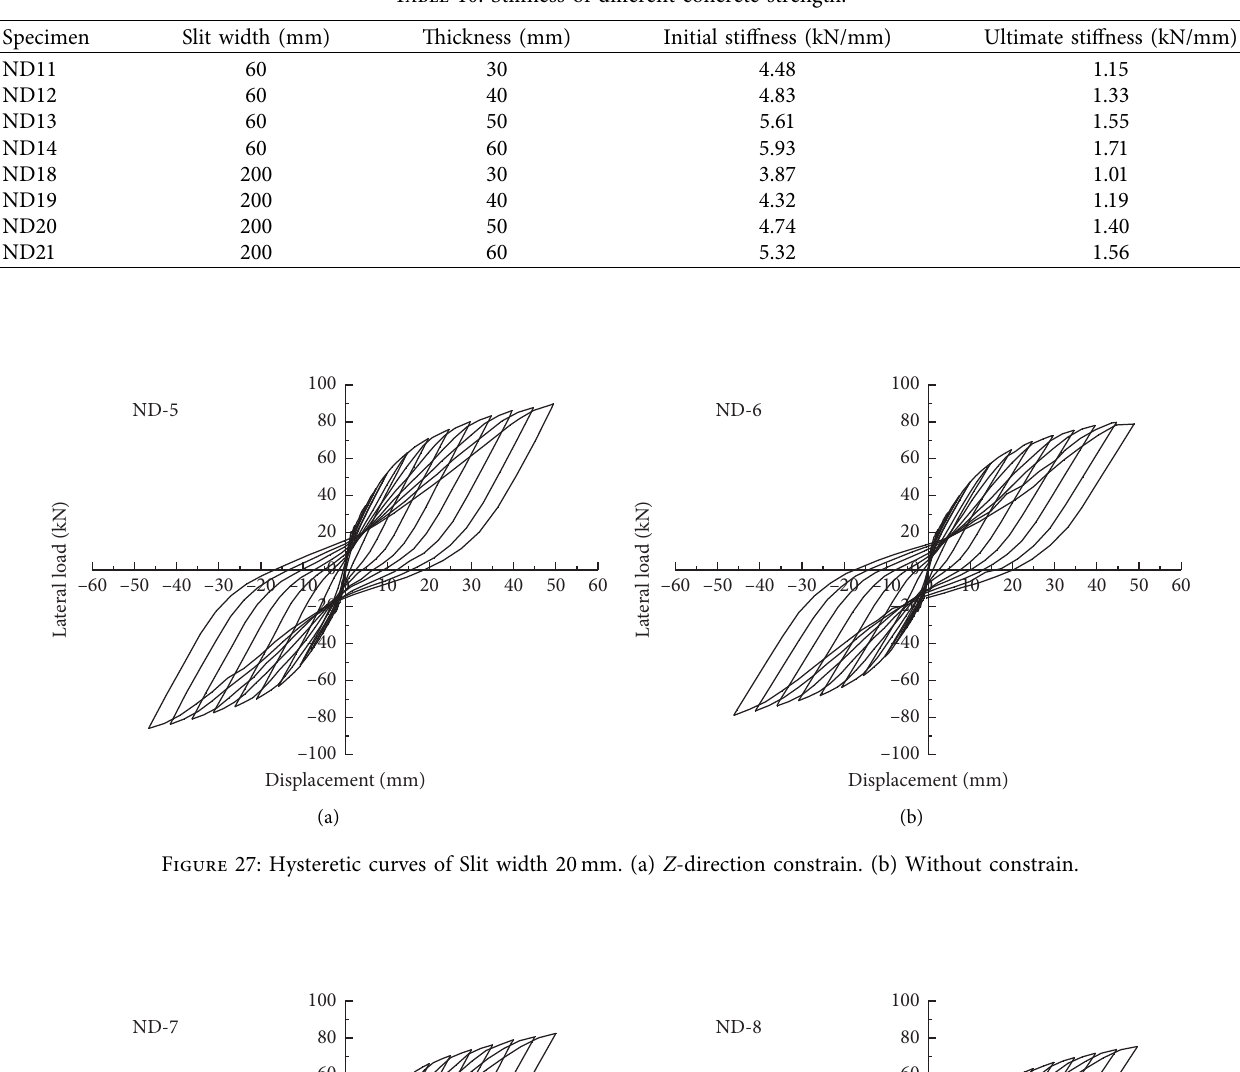
Table 10: Stiffness of different concrete strength.